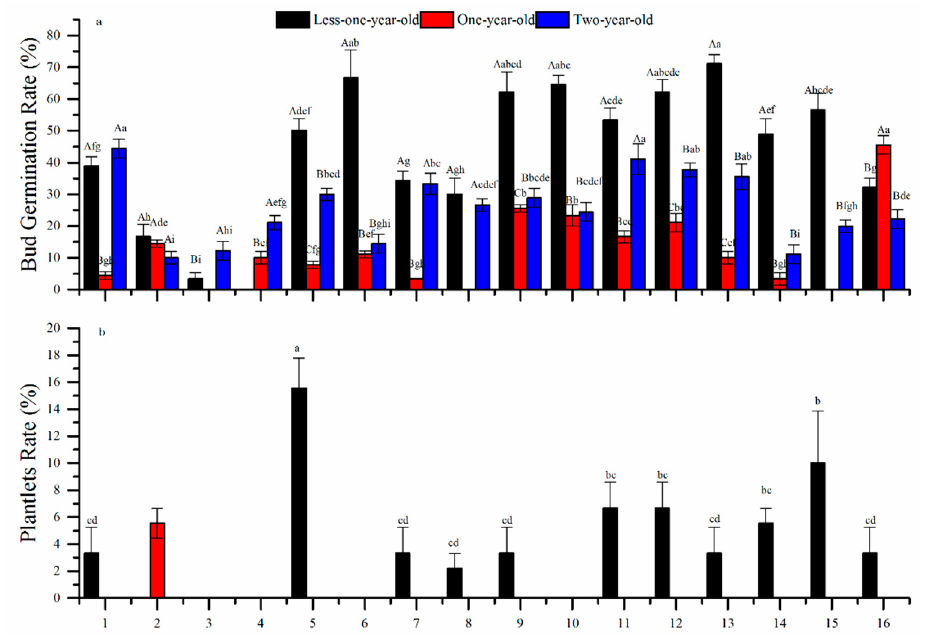
Figure 4. Effects of growth hormones at differing concentrations on the ( a ) bud germination rate and ( b ) plantlet formation rate of Chinese-fir leaf cuttings. Different lowercase letters above the columns indicate significant differences ( p < 0.05) between different treatments. Different capital letters indicate significant differences ( p < 0.05) between different leaf ages. The numbers 1 to 16 on the horizontal axis refer to the 16 treatments in Table 1.